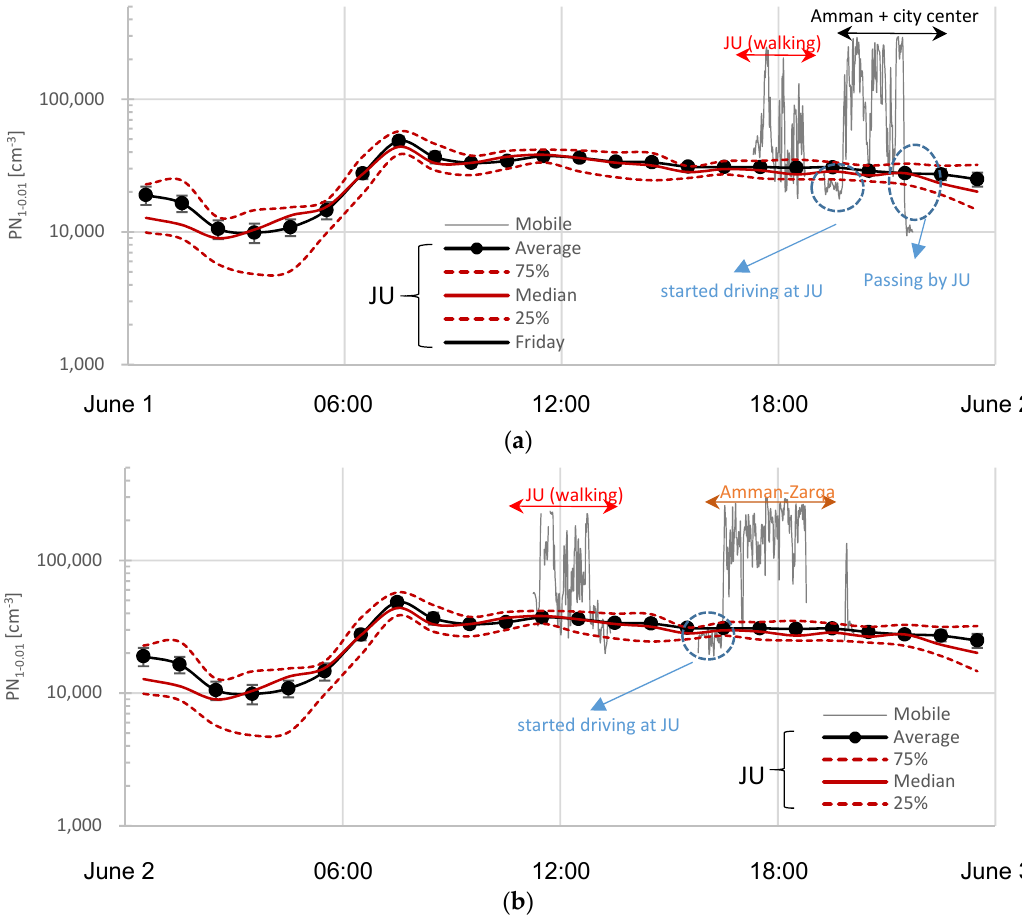
Figure 4. Submicron particle number concentrations (PN 1–0.01 ) measured during mobile campaigns on ( a ) June 1st and ( b ) June 2nd. The results are plotted along with the diurnal patterns observed at the reference urban background (campus of the University of Jordan).